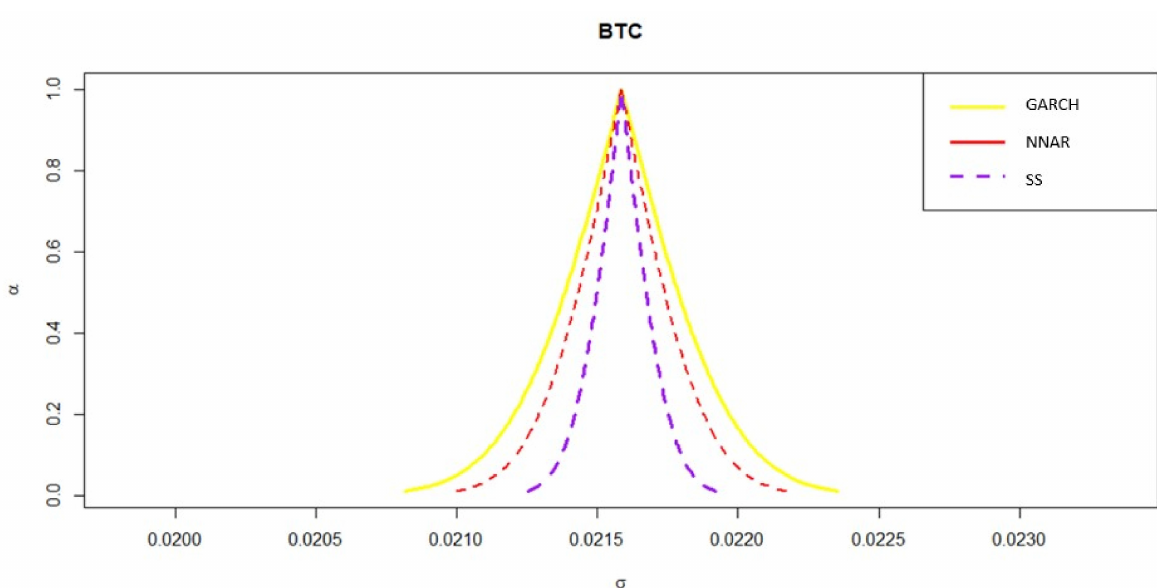
Figure 10. Volatility confidence interval for